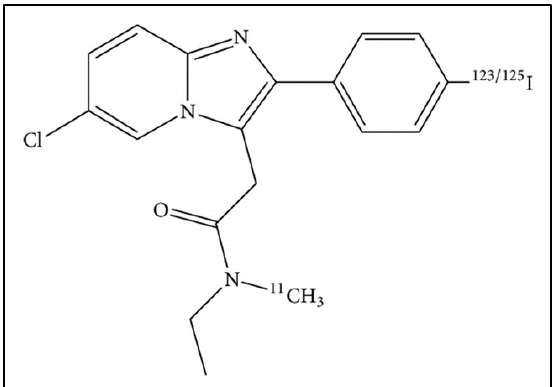
Figure 6. Chemical structure of 6-chloro-2-(4′-iodophenyl)-3-(N,N-methylethyl)imidazo[1,2-a]pyri- dine-3-acetamide (CLINME) radiolabeled with iodine-123, a compound of the 2-arylimidazo[1,2- a]pyridine-3-acetamide